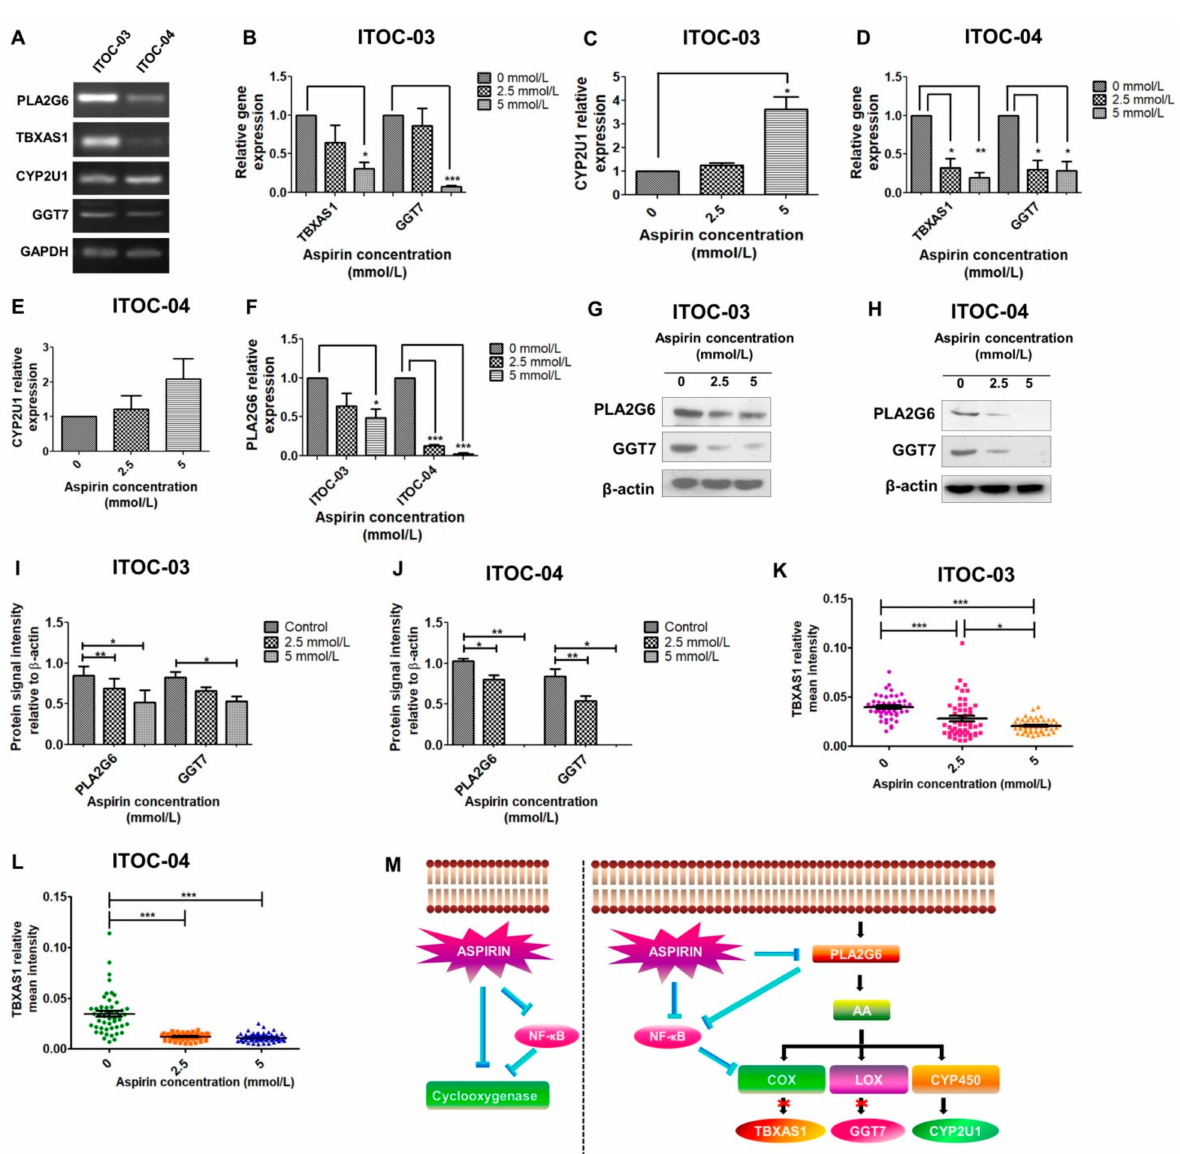
Figure 2. PLA2G6 inhibition by aspirin leads to down-regulation of AAM pathway components. ( A ) Expression of AAM pathway components PLA2G6, TBXAS1, GGT7 and CYP2U1 in GB-SCC cells as measured by RT-PCR. ( B – E ) Relative expression of TBXAS1, GGT7 and CYP2U1 in GB-SCC cells treated with aspirin as measured by qRT-PCR. The error bars represent the mean ± SEM (n = 3). Stu- dent’s t test was used for statistical analysis, * p < 0.05, ** p < 0.01, *** p < 0.001. ( F ) Relative expression of PLA2G6 in GB-SCC cells treated with aspirin as measured by qRT-PCR. The error bars represent the mean ± SEM (n = 3). Student’s t test was used for statistical analysis, * p < 0.05, *** p < 0.001. ( G , H ) Immunoblots depicting expression profile of PLA2G6 and GGT7 in aspirin-treated GB-SCC cells. β -actin used as endogenous control. ( I , J ) Quantification of PLA2G6 and GGT7 signal intensity relative to β -actin levels. The error bars represent the mean ± SEM (n = 3). Student’s t test was used for statistical analysis, * p < 0.05, ** p < 0.01. ( K , L ) Scatter plot representation of the mean